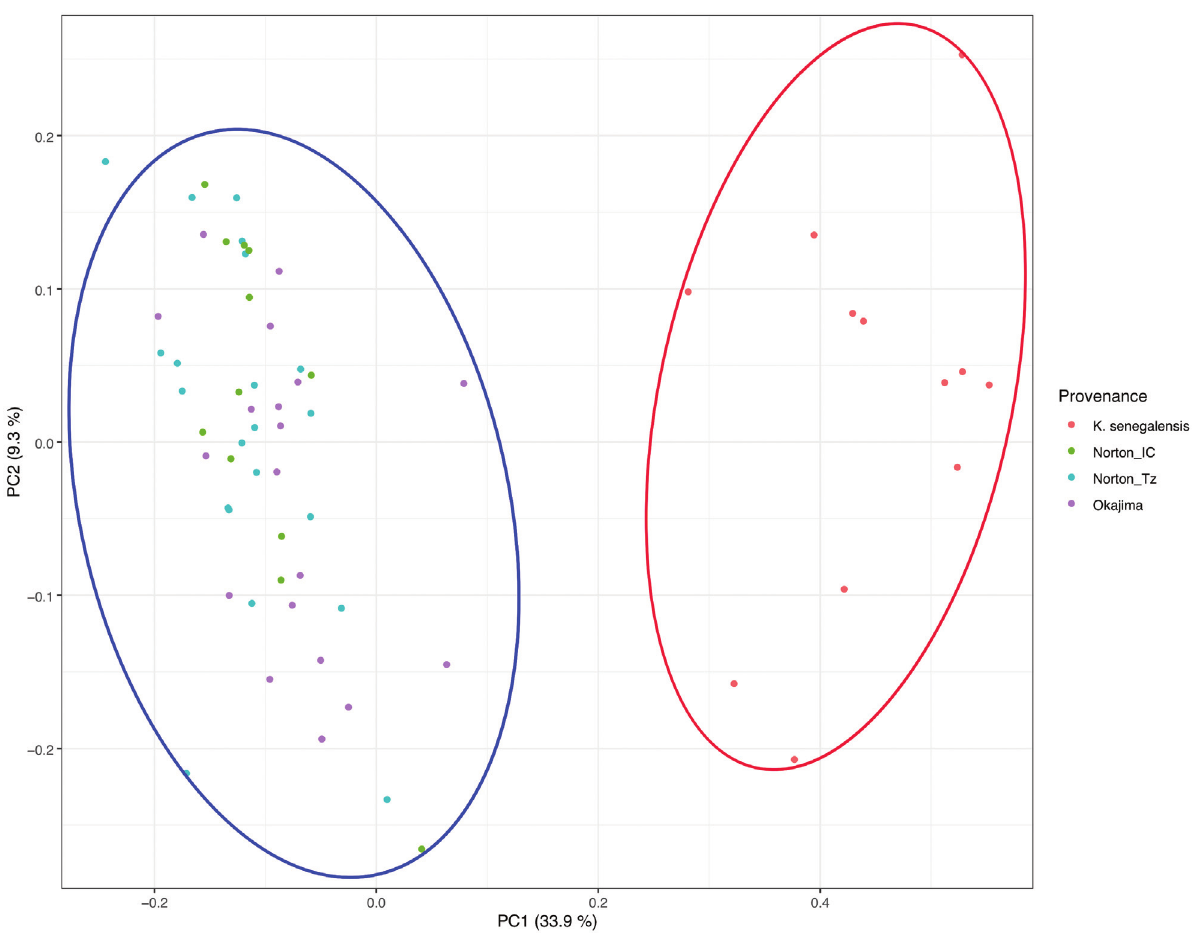
Figure 1 - Genetic distance between samples obtained from a principal component analyses (PCA), with the first component (PC1) in the x-axis and the second (PC2) in the y-axis. The biplot depicts a strong genetic structure between species but not between the K. grandifoliola provenances. PCA was per- formed with a genetic distance matrix using Rogers (1972) modified by Wright (1978). Cophenetic correlation was high (r = 0,90) and significant ( p -value < 0.0001) by the Mantel